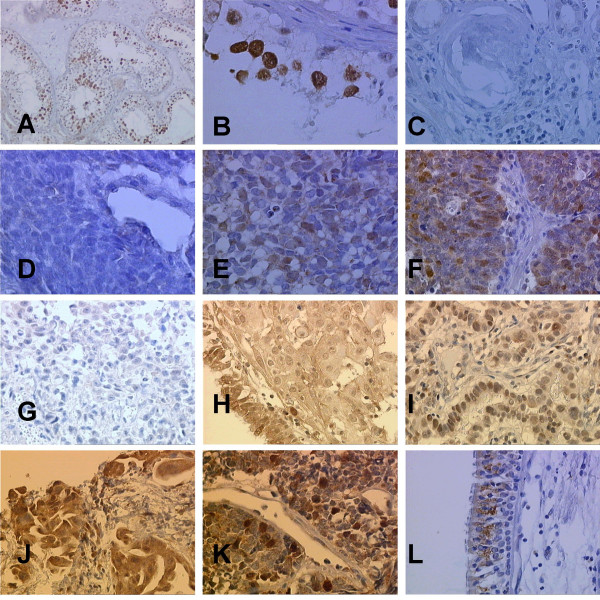
Immunohistochemical staining of PTTG-1. (A + B) positive control of germ cells in testis; (C) negative control of uropoietic tubuli stroma cells and globuli of the kidney; SCLC with negative PTTG-1 expression (D); low PTTG-1 expression (E) and strong PTTG-1 expression (F). Adenocarcinoma (NSCLC) with negative PTTG-1 expression (G), low PTTG-1 expression (H) and strong PTTG-1 expression (I). Squamous cell carcinoma (NSCLC) with low PTTG-1 expression (J) and strong PTTG-1 expression (K). (L), note the positive cytoplasmatic staining of normal bronchial epithelium.